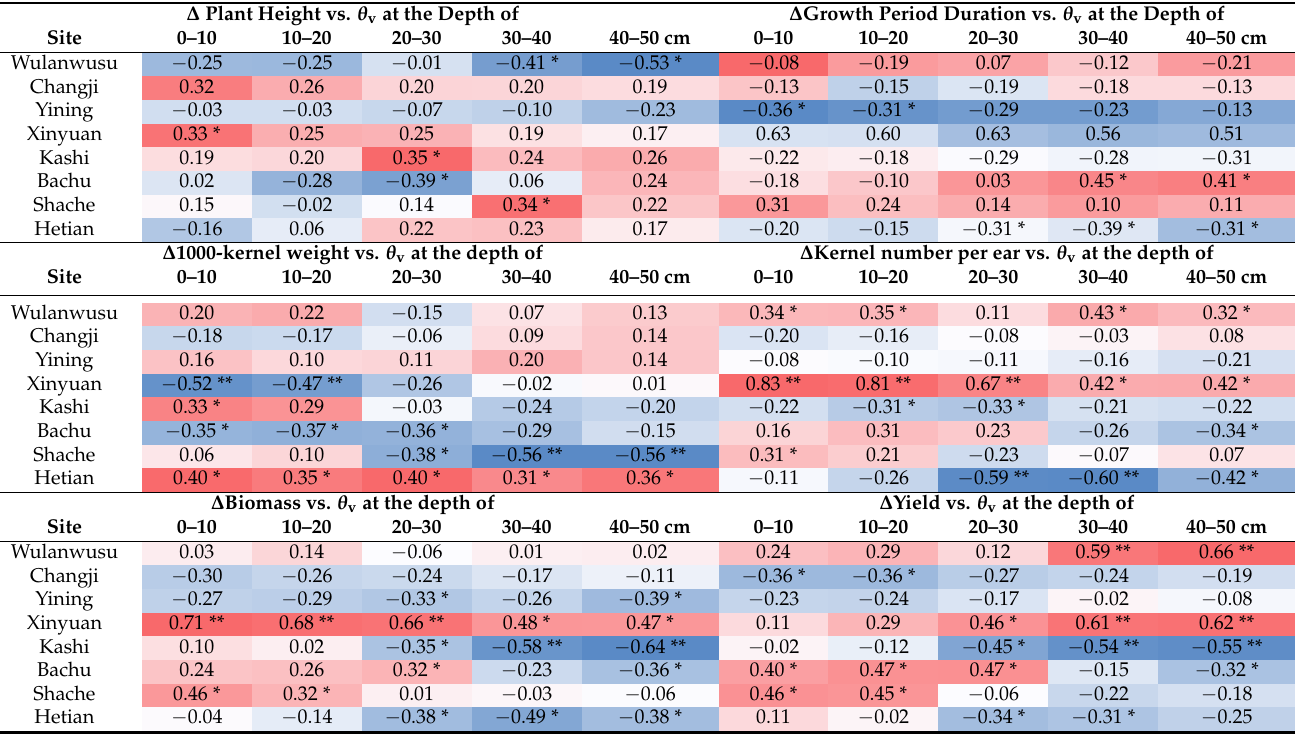
Table 8. The Pearson correlation coefficients between the first differences of six growth- and yield-related indices and the mean volumetric soil water content during winter wheat growth period ( θ v ) at different depths over 1981–2017 at the eight sites in Xinjiang,